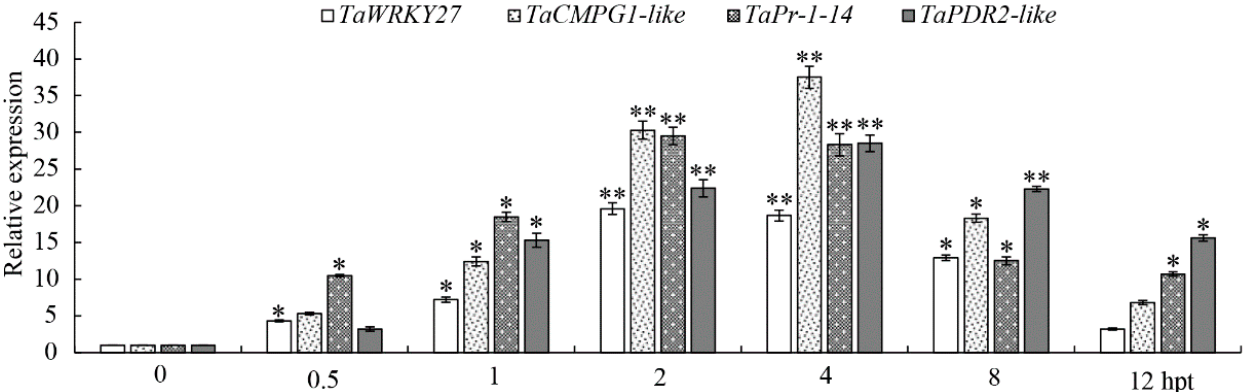
Figure 3. Expression characteristics of four pathogenic-associated molecular pattern-triggered immune (PTI) candidate marker genes induced by chitin in the leaves of wheat cultivar CN19. The relative expression of the four genes was examined by qRT-PCR. Bars represent standard deviations (SD), which were calculated from 3 independent biological replicates ( n = 3). Asterisks indicate significant differences calculated using Student’s t -test. (* p < 0.05, ** p < 0.01). 0 hpt, un-treated wheat plants. 0.5–12 hpt represent 0.5, 1, 2, 4, 8, and 120 h post-treatment.